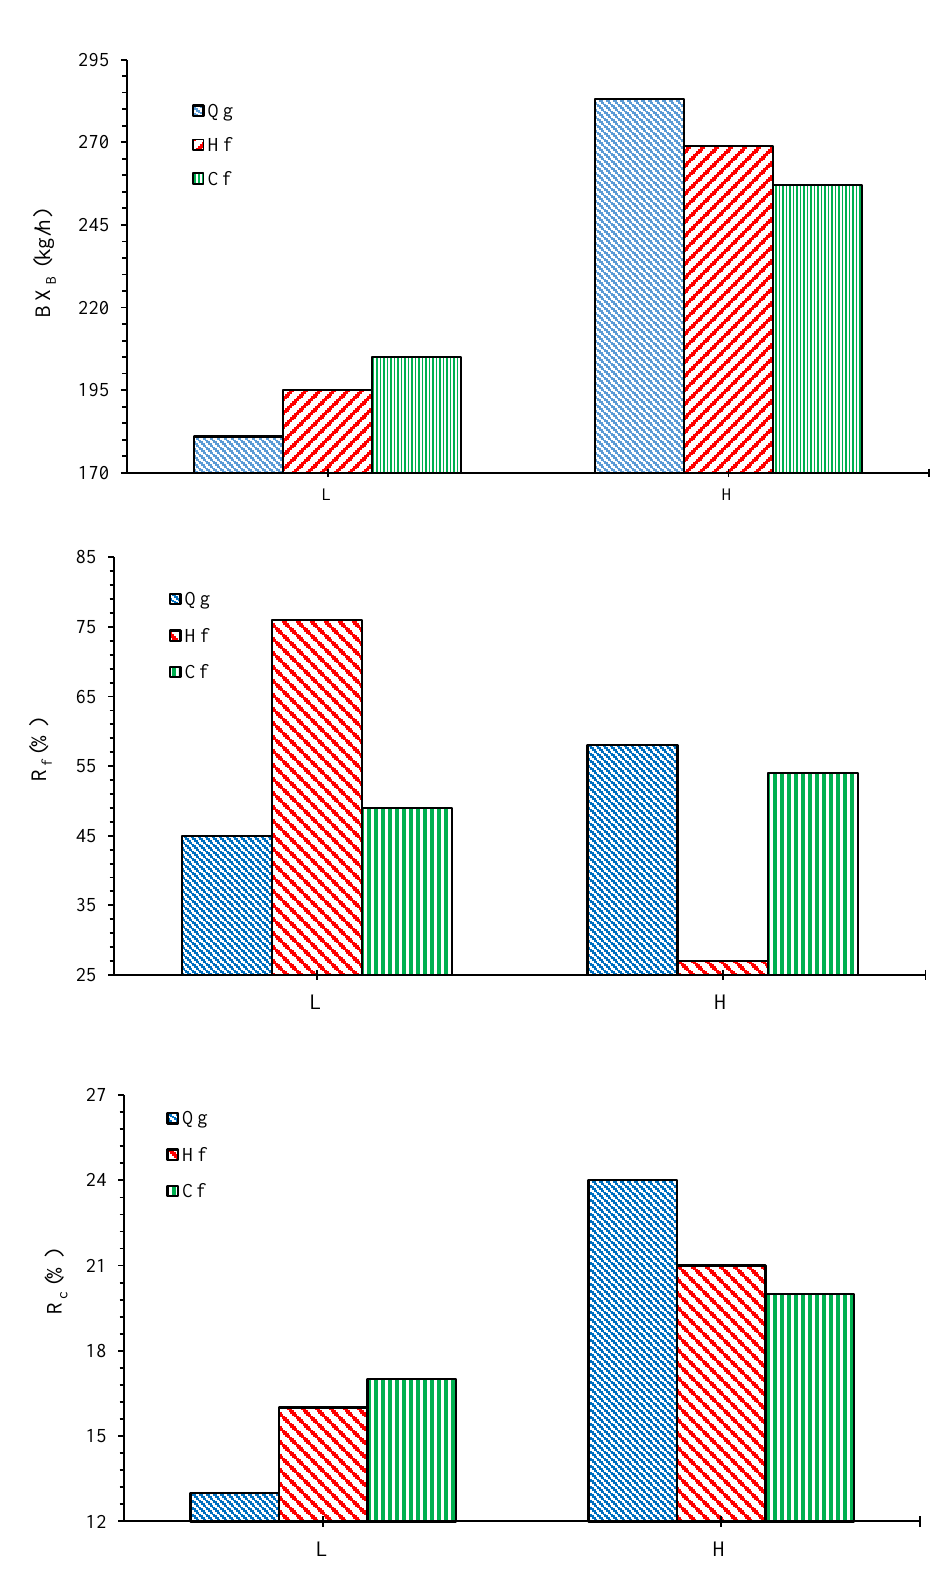
Figure 3. Effect of air flowrate (Q g ), froth depth (H f ), and frother dosage (C f ) on the flowrate of the minerals into froth phase (BX B ), froth recovery (R f ), and collection zone recovery (R c ) at two different conditions (L: Q g = 45 m 3 /h, C f = 70 mL/min, H f = 5 cm, and H: Q g = 146 m 3 /h, C f = 150 m L/min, H f = 30